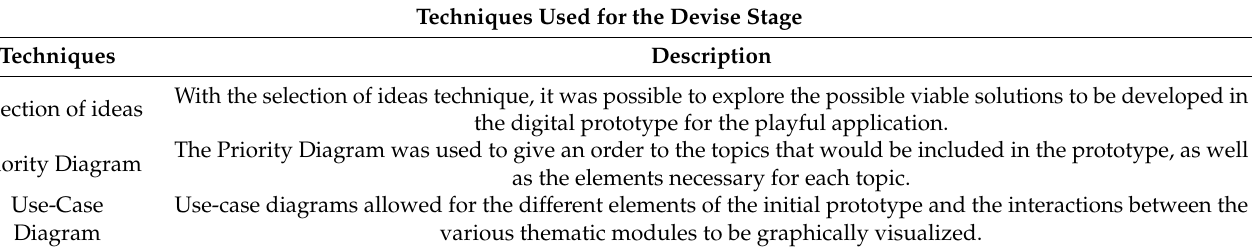
Table 5. Description of techniques used in the Devise stage.